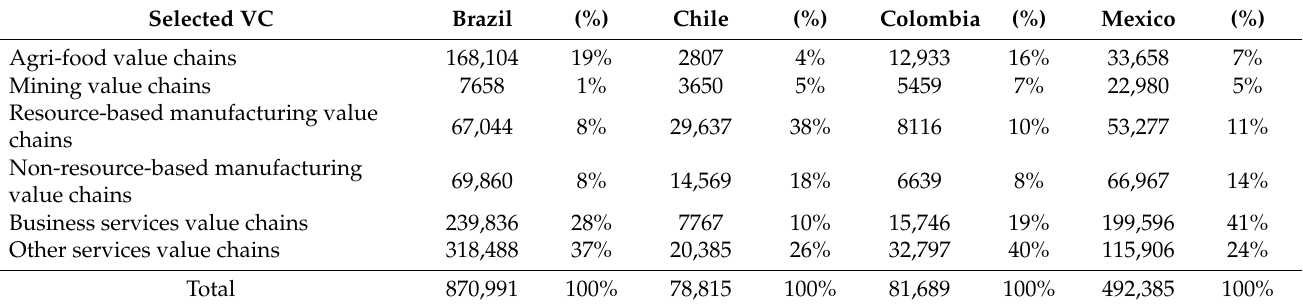
Table 4. Total CO 2 emissions (Gg) from EDGAR database.